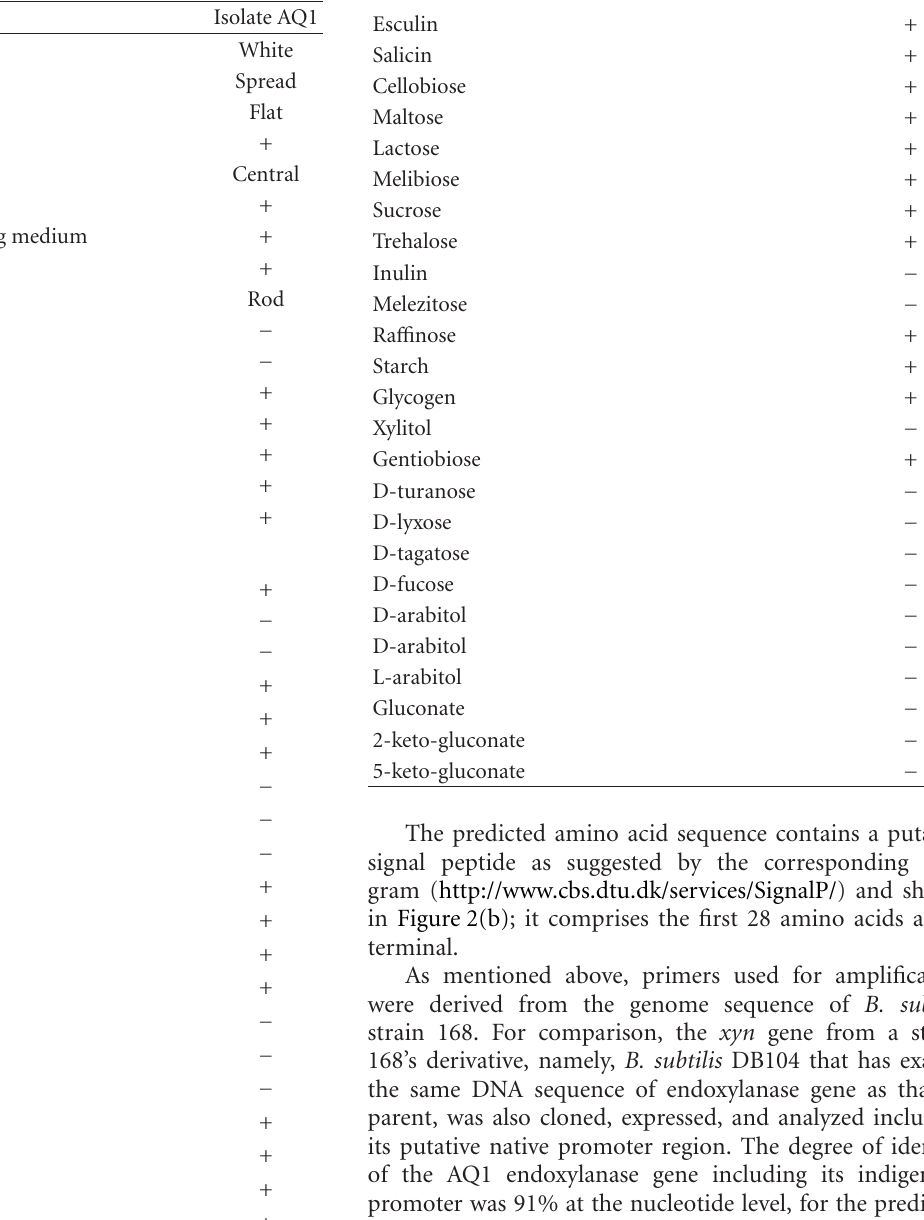
Table 1: Physiological and biochemical characteristics of isolates AQ1 based on the API 50 CHB system and other tests described in Materials and Methods. (+) presence; ( − ) absence.